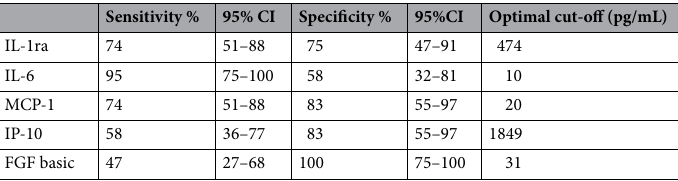
Table 2. Prediction of respiratory failure by plasma cytokine analyses.